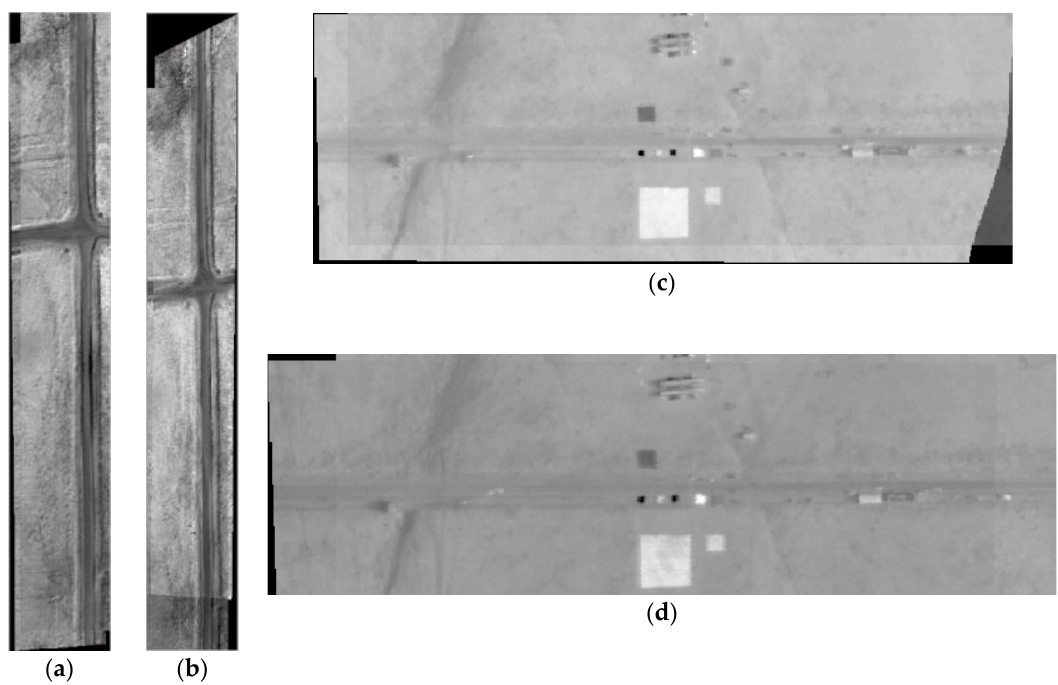
Figure 7. Resulting mosaic images for the brightness temperature maps for the four pairs, namely ( a ) LWIR2 a –LWIR2 b , ( b ) LWIR2 a –LWIR2 c , ( c ) LWIR3 a –LWIR3 b , and ( d ) LWIR3 a –LWIR3 c .